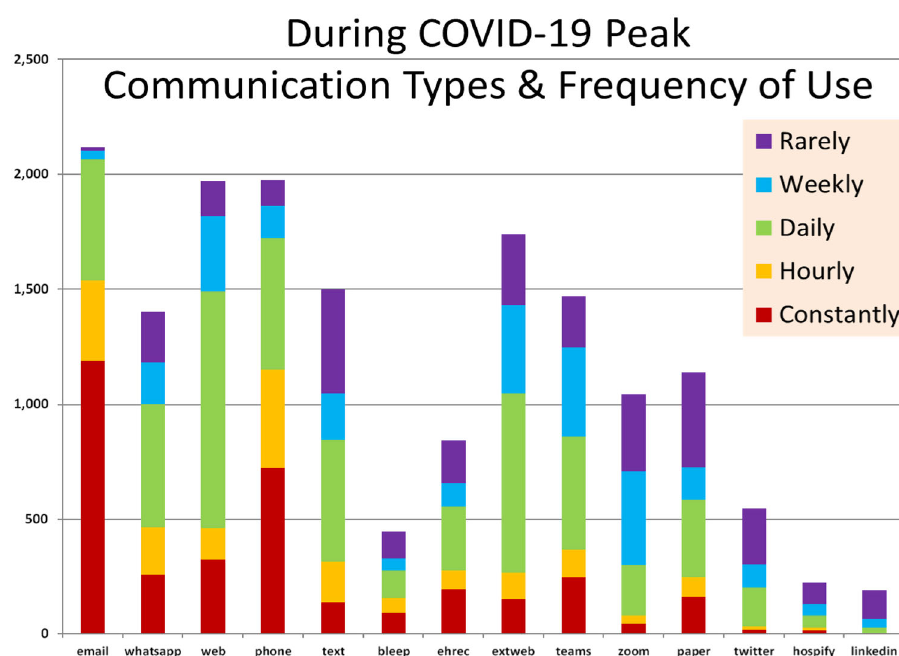
Fig. 2 Figure pertaining to data collected from survey Section 2, including the communication platforms reportedly used by participants and frequency of use during COVID-19.